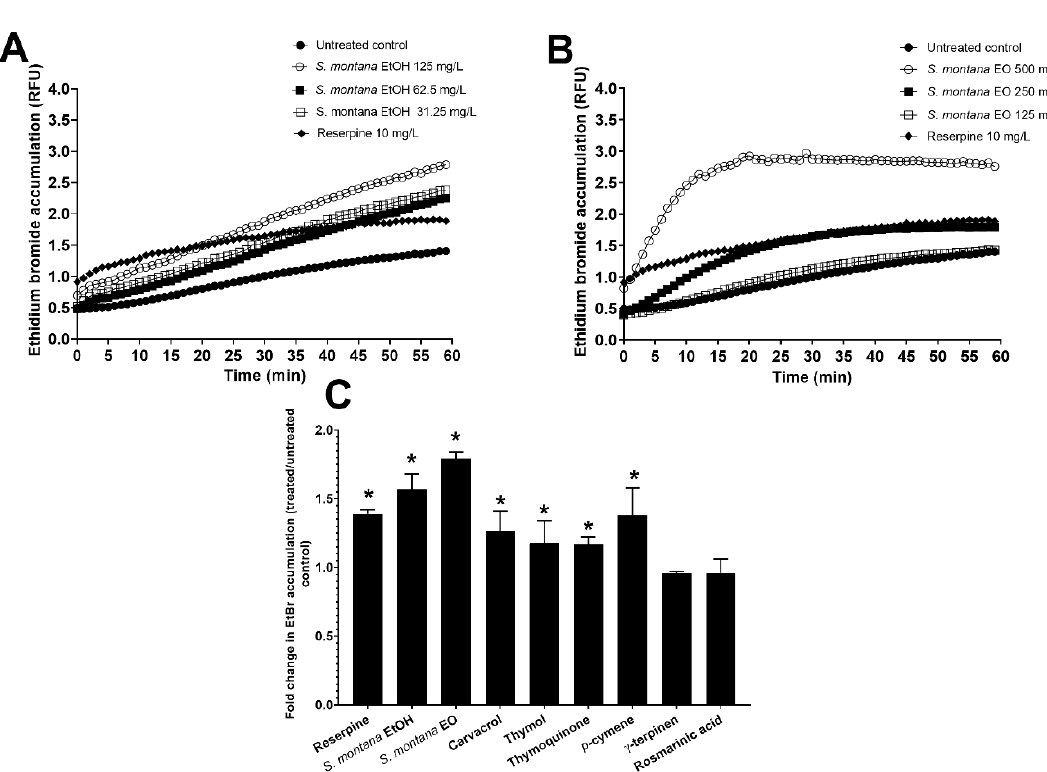
Figure 2. E ff ect of S. montana ( A ) ethanolic extract (EtOH) and ( B ) essential oil on membrane integrity Figure 2 . Effect of S. montana ( A ) ethanolic extract (EtOH ) and ( B ) essential oil on membrane disruption in C. jejuni NCTC 11,168 in sub-inhibitory concentrations of 0.5 × (125 and 500 mg / L), 0.25 × integrity disruption in C. jejuni NCTC 11,168 in sub-inhibitory concentrations of 0.5× (125 and 500 (62.5 and 250 mg / L), and 0.125 × (31.25 and 125 mg / L) of the minimal inhibitory concentration (MIC), mg/L), 0.25× (62.5 and 250 mg/L), and 0.125× (31.25 and 125 mg/L) of the minimal inhibitory presented in relative fluorescent units (RFU) measured for 1 h in 1 min intervals. Fold increase in concentration (MIC), presented in relative fluorescent units (RFU) measured for 1 h in 1 min EtBr accumulation ( C ) in the treated culture compared to untreated culture is shown for S. montana intervals. Fold increase in EtBr accumulation ( C ) in the treated culture compared to untreated ethanolic extract and essential oil, and 6 pure compounds, at the subinhibitory concentration of 0.25 × culture is shown for S. montana ethanolic extract and essential oil, and 6 pure compounds, at the MIC. Reserpine at 10 mg / L was used as a positive control. A higher value presents higher accumulation subinhibitory concentration of 0.25× MIC. Reserpine at 10 mg/L was used as a positive control. A of ethidium bromide and thus a lower activity and inhibition of C. jejuni e ffl ux pumps. *, p < 0.05 (Student’s t